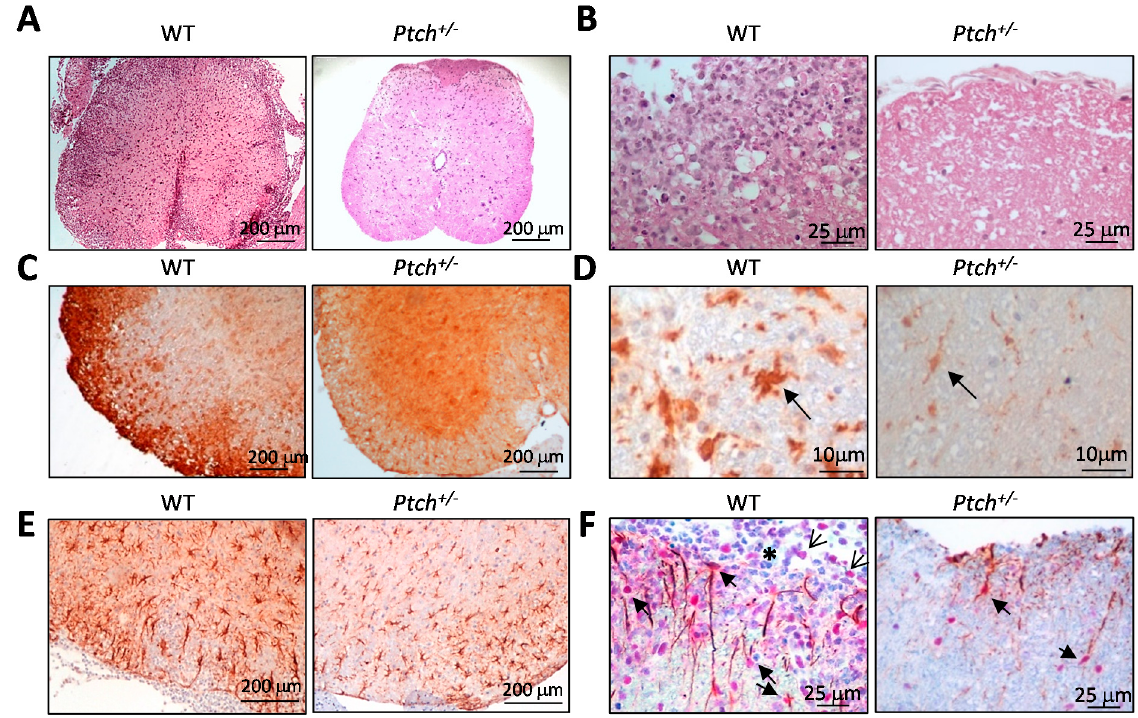
Figure 7. Histological and immuno-histochemical analyses of spinal cord cross-sections from ptch +/ − and wt mice. MOG 35–55 -inoculated mice were sacrificed on day 20 after inoculation, and spinal cord sections were subjected to haematoxilin-eosin staining ( A , B ) or immuno-histochemical analysis with antibodies against CD11b ( C ), Iba-1 ( D ) and GFAP ( E ) or double staining for GFAP and Stat3 ( F ). Arrows in D point to microglia with typical activated or resting morphologies in wt or ptch +/ − samples, respectively. Thick arrows in F indicate double-positive cells with anti-GFAP (brown cytoplasm) and anti-Stat3 (red nuclei), thin arrows show infiltrating immune cells and the asterisk marks polymorphic leukocytes. Magnitude scales are indicated on each micrograph.